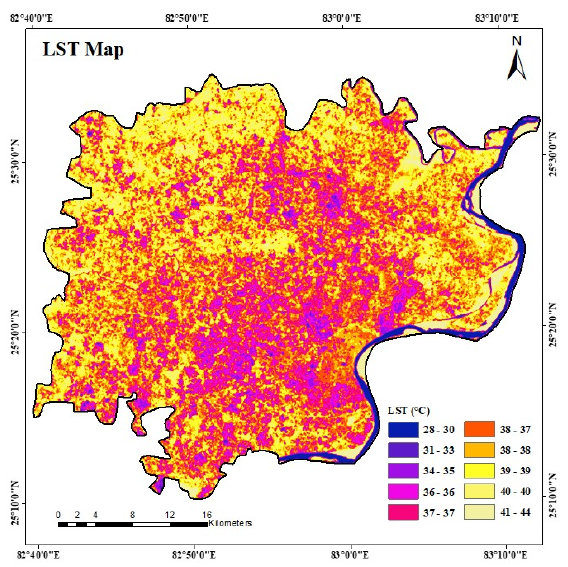
Figure 3. Land surface temperature (LST) map of Varanasi city developed using Landsat 8 imagery .